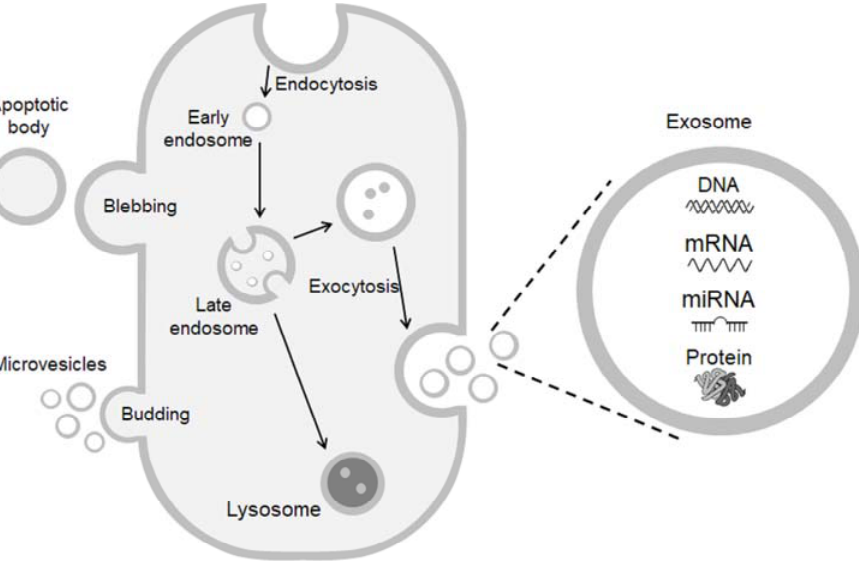
Figure 1. Exosomes’ formation. Exosomes containing DNA, mRNA, miRNA, and proteins are formed by the inward budding of late endosomes and the formation of small vesicles that will be released into the extracellular space through exocytosis.